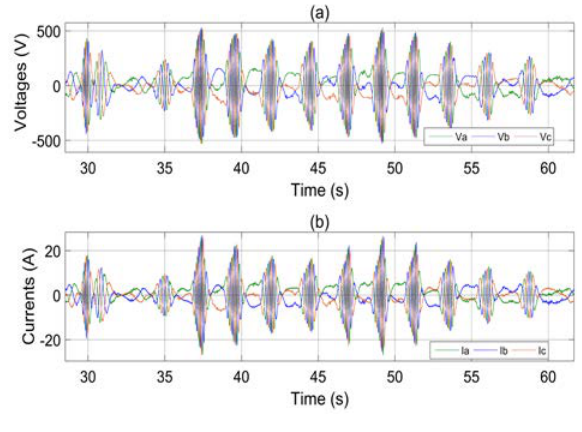
Fig. 11. PMLG output in Case III. (a) Phase voltages, (b) Controlled